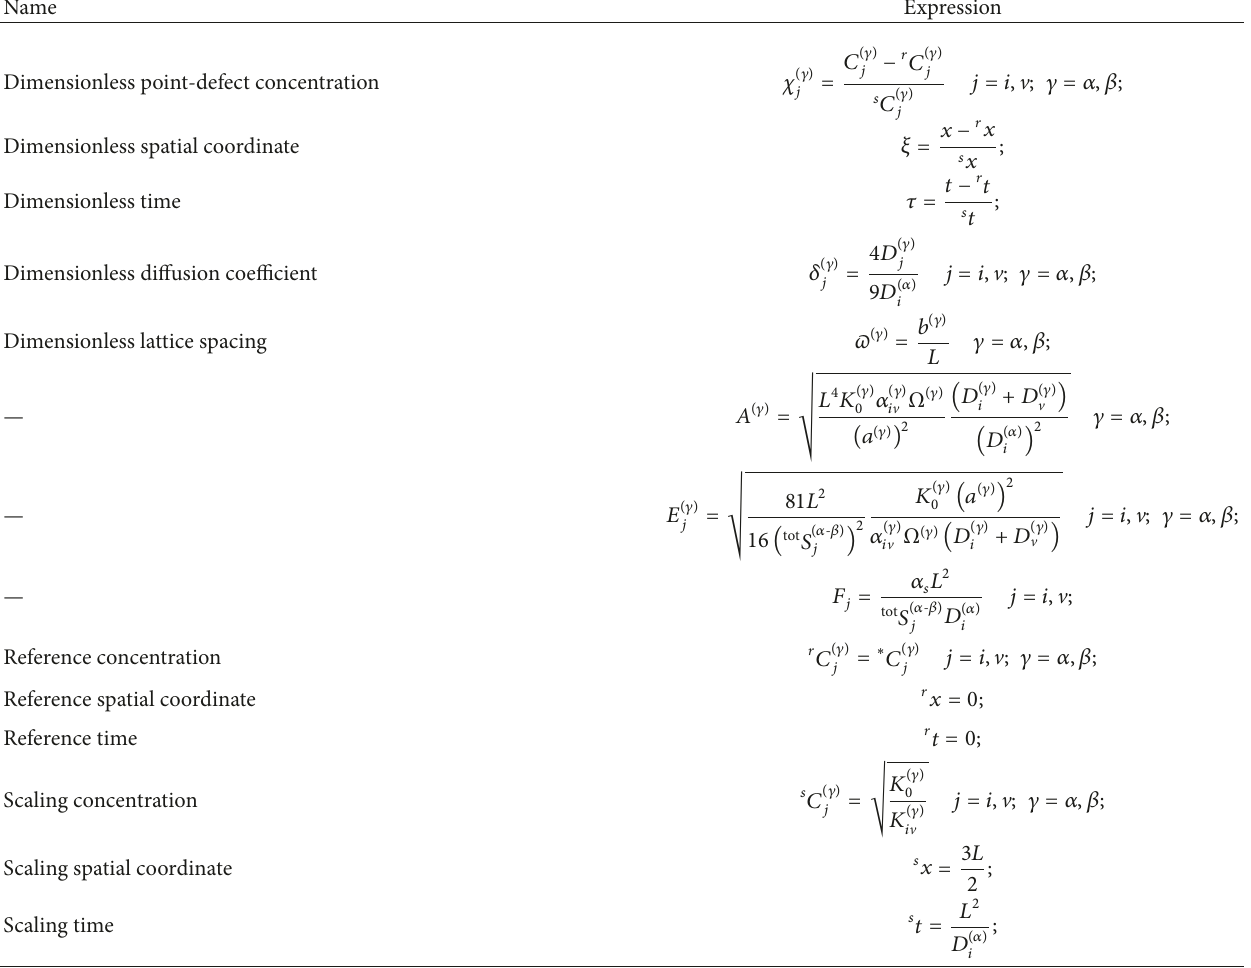
Table 1: Dimensionless variables and parameters and scaling and reference